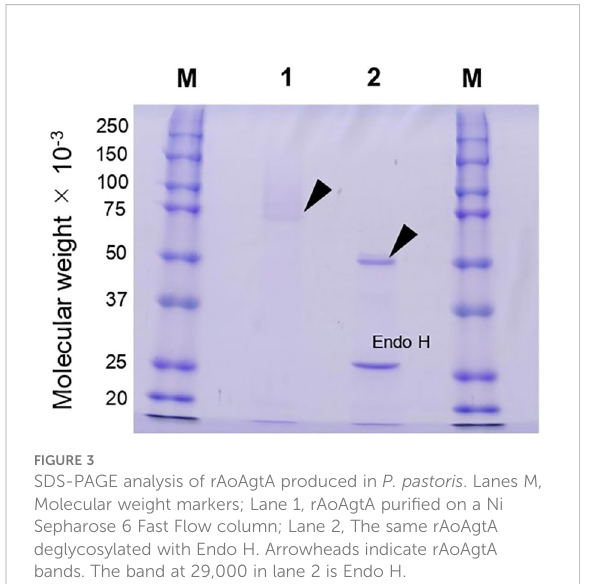
FIGURE 3 SDS-PAGE analysis of rAoAgtA produced in P. pastoris . Lanes M, Molecular weight markers; Lane 1, rAoAgtA puri fi ed on a Ni Sepharose 6 Fast Flow column; Lane 2, The same rAoAgtA deglycosylated with Endo H. Arrowheads indicate rAoAgtA bands. The band at 29,000 in lane 2 is Endo H.